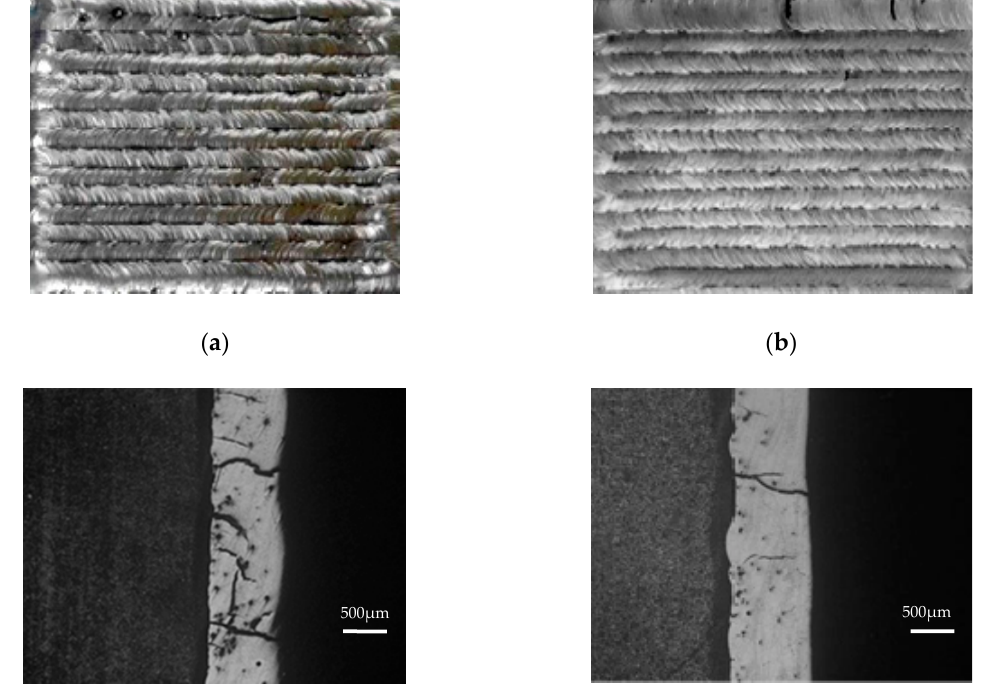
Figure 1. Morphology of the coatings before and after laser re-melting.